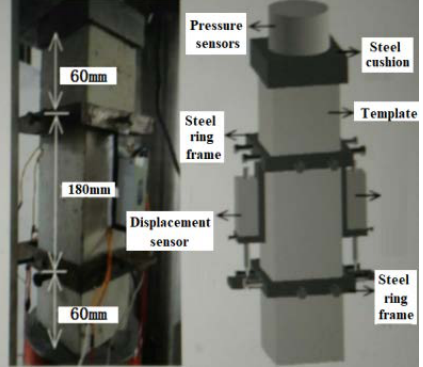
Figure 4. Picture of the stress–strain loading concrete.